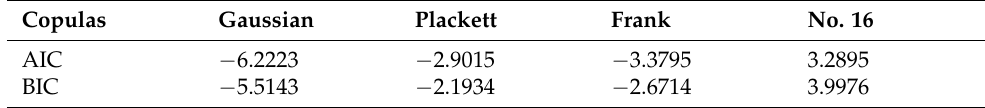
Table 11. AIC and BIC scores of different